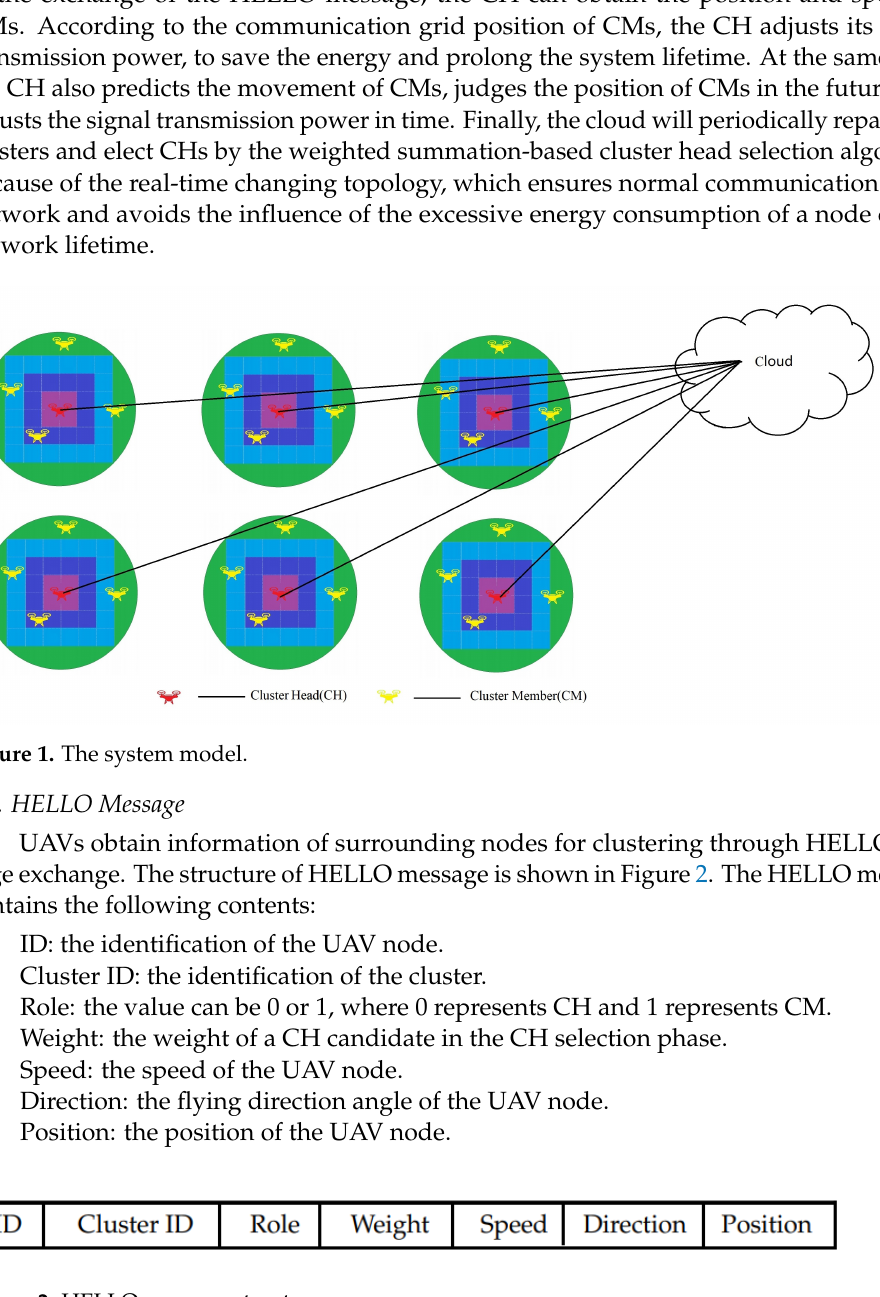
Figure 2. HELLO message